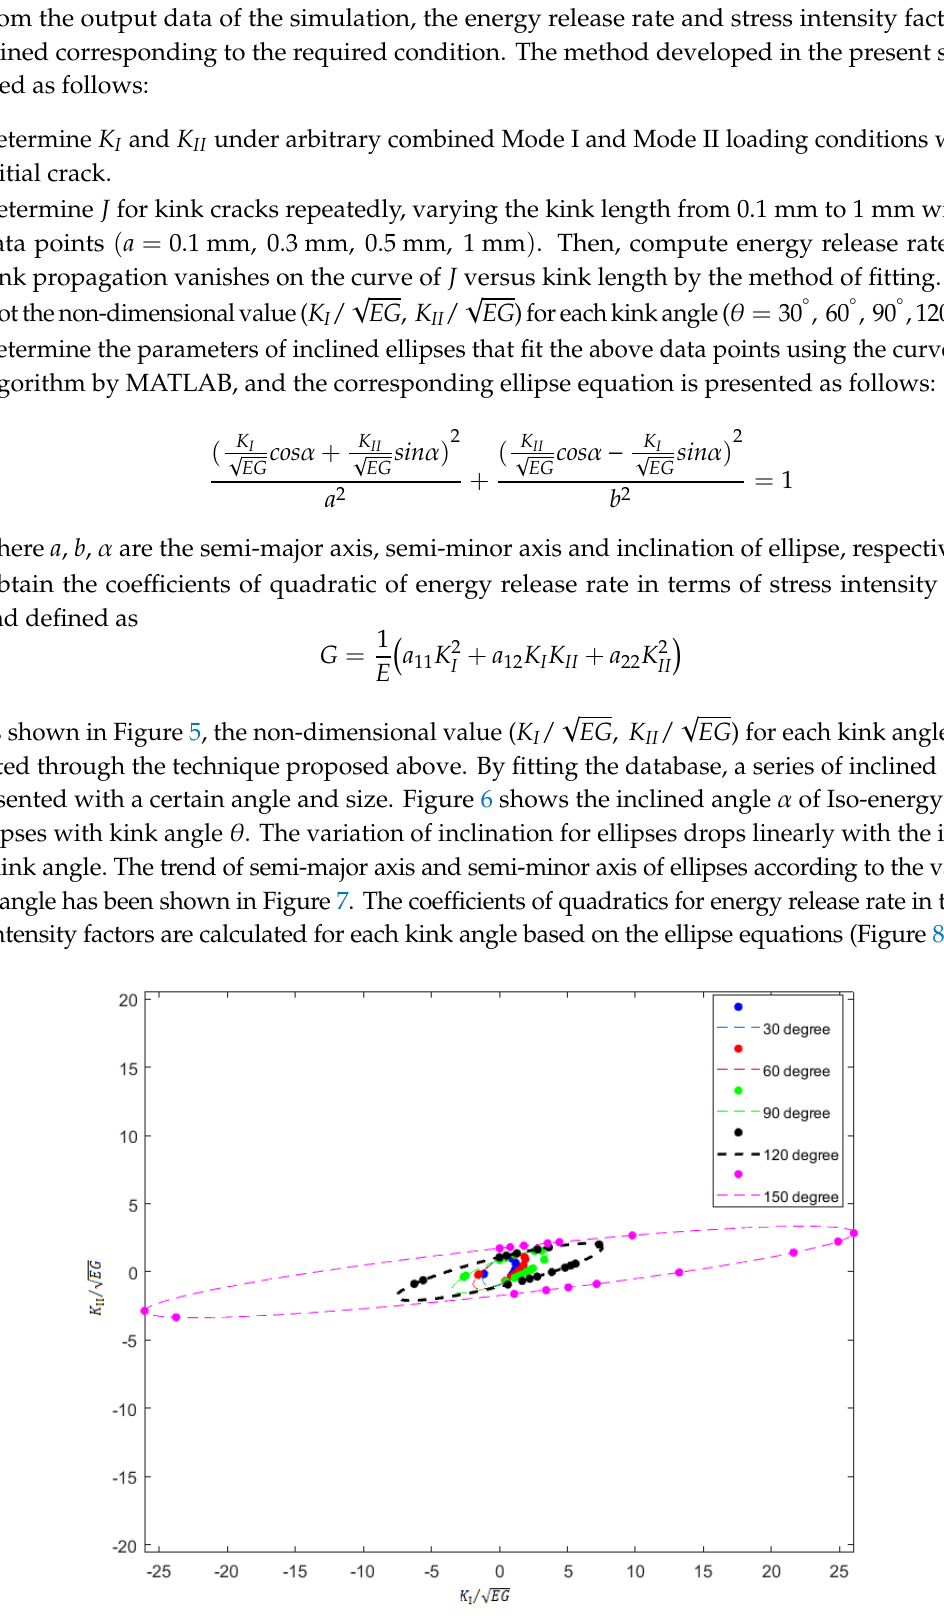
Figure 5. Iso-energy release rate ellipses on normalized mixed mode stress intensity Figure 5. Iso ‐ energy release rate ellipses on normalized mixed mode stress intensity factors.